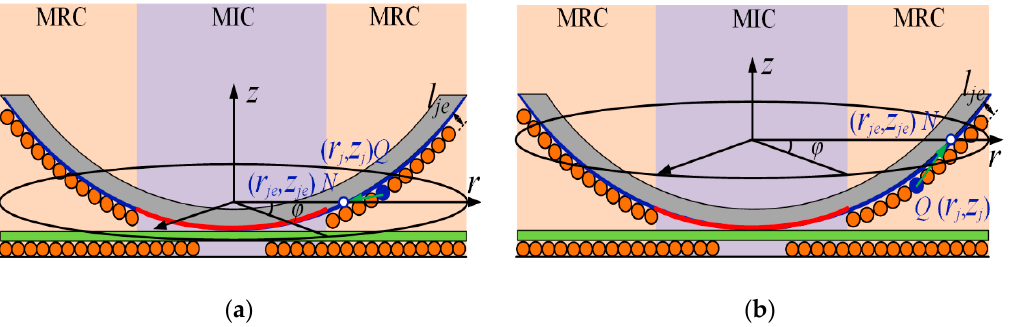
Figure 6. Wok heating using MIC and magnetic resonance coupling (MRC) with frustum coil. ( a ) z j > z je . ( b ) z j ≤ z je .